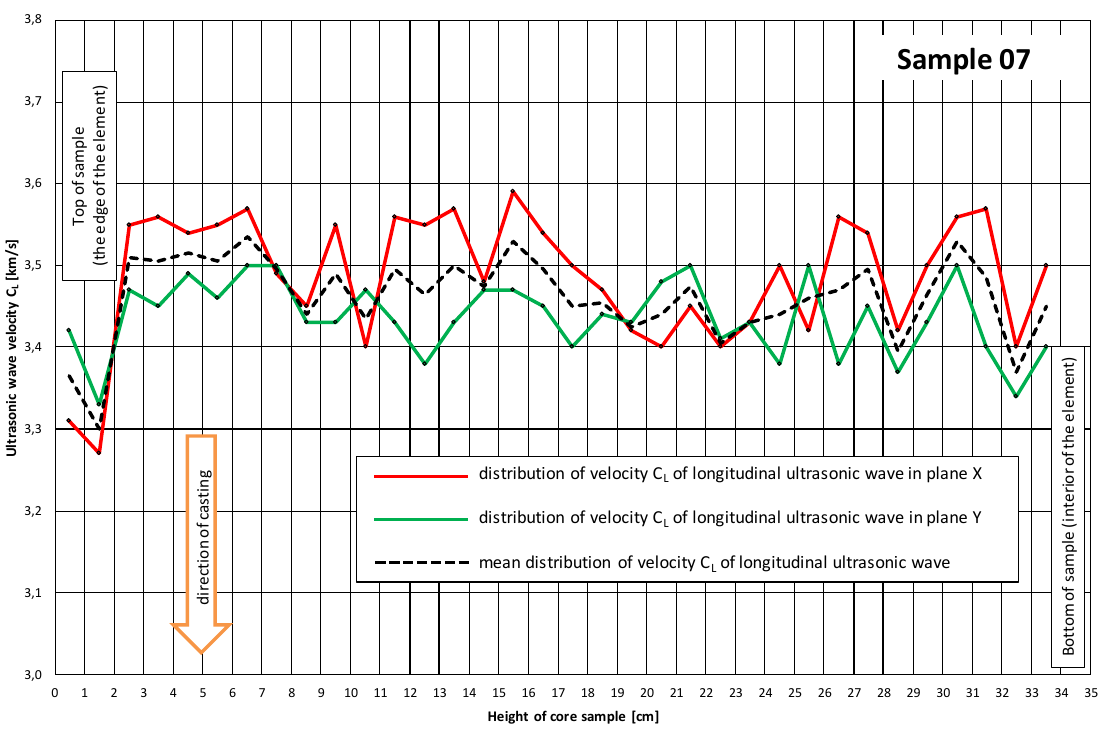
Figure 4. Exemplary distribution of velocity C L of longitudinal ultrasonic wave along height of sample 07 taken parallel with the top surface of the slab.